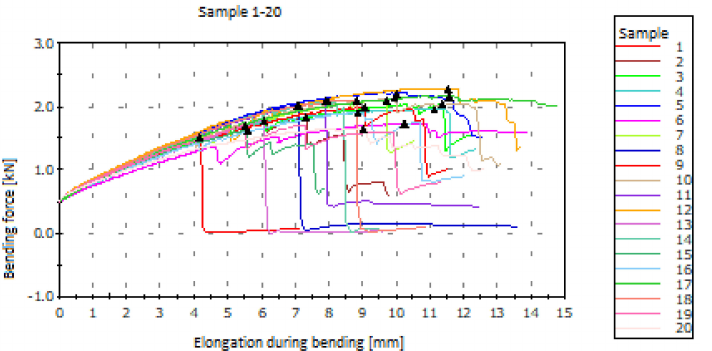
Figure 10. Results of the bending strength test for spruce wood elements obtained during the test at the INSTRON stand. Table 1. Results of the bending strength test for spruce wood elements.